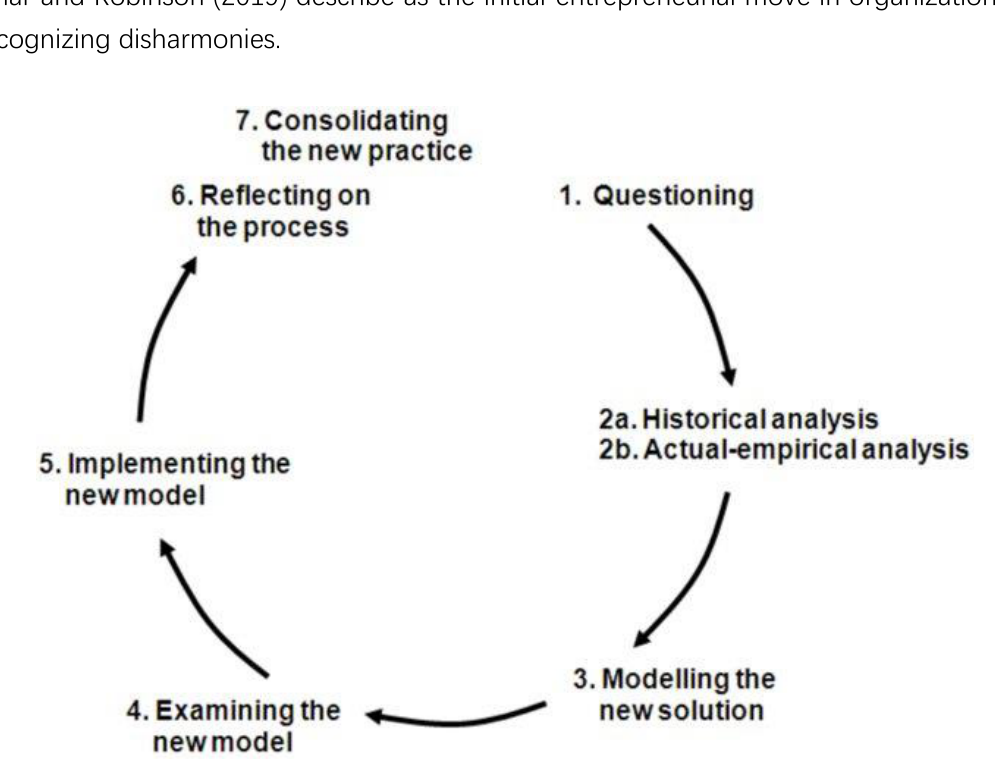
Figure 2 : Expansive learning cycle (adapted from Engeström